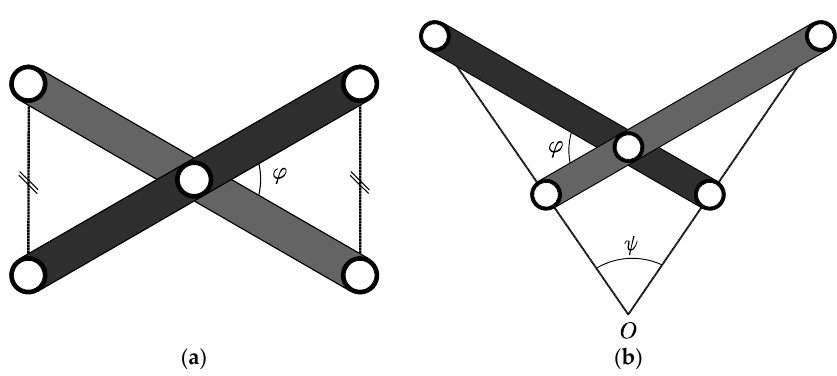
Figure 2. Two types of scissor-like element (SLE): ( a ) translational; ( b ) polar.